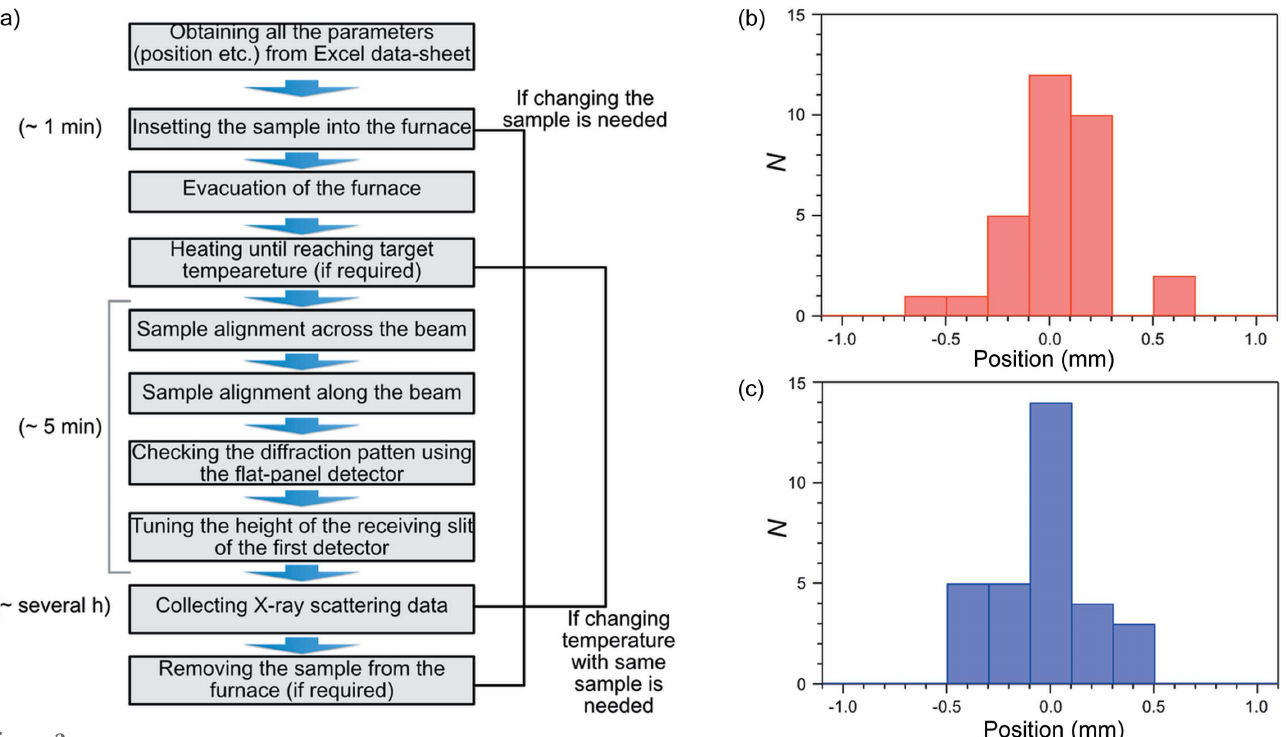
Figure 2 Automated X-ray total scattering measurement procedure and reproducability of the sample position. ( a ) Automated X-ray scattering measurement procedure. This cycle is automatically repeated until all the measurement conditions have been completed. The typical time required for each step is also shown. ( b ) Histogram of the sample position across the beam. ( c ) Histogram of the sample position along the beam. Note that N represents the number of appearances during the reproducability